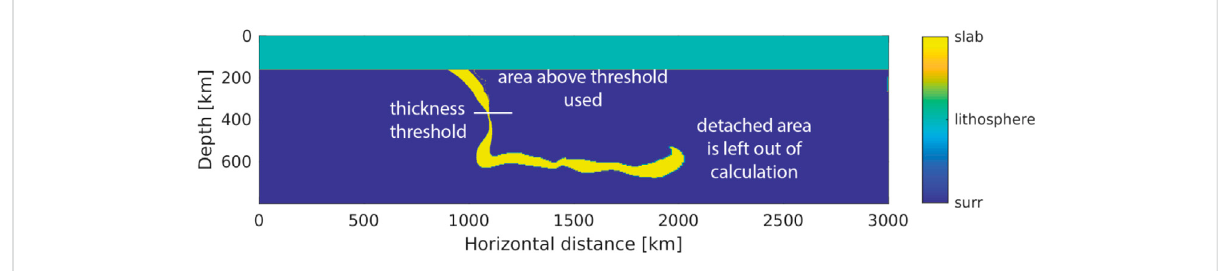
FIGURE A2 Slab identi fi cation of the slab pull calculation program for the reference model. The algorithm excludes everything below the necking level (whichno longer haslithospherictemperatures) wheretheslabdetaches, andeverything above thelithosphere-asthenosphereboundaryatadepth of 140 km. The resulting force estimate provides reasonable size estimates (e.g., Sandiford et al., 2005), despite these